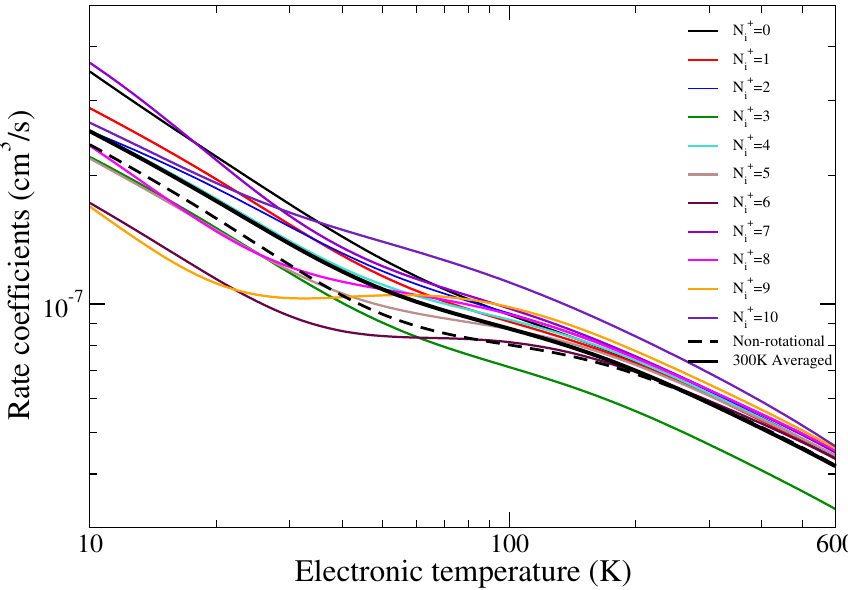
Figure 4. Maxwell isotropic rate coefficients for the dissociative recombination CH + ( X 2 Σ + ) with = 0 as a function of initial rotational level, N + v + i